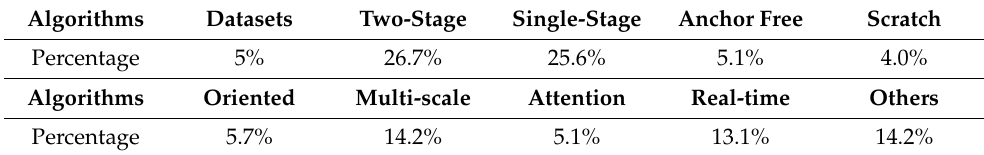
Table 12. The percentage of each algorithm.